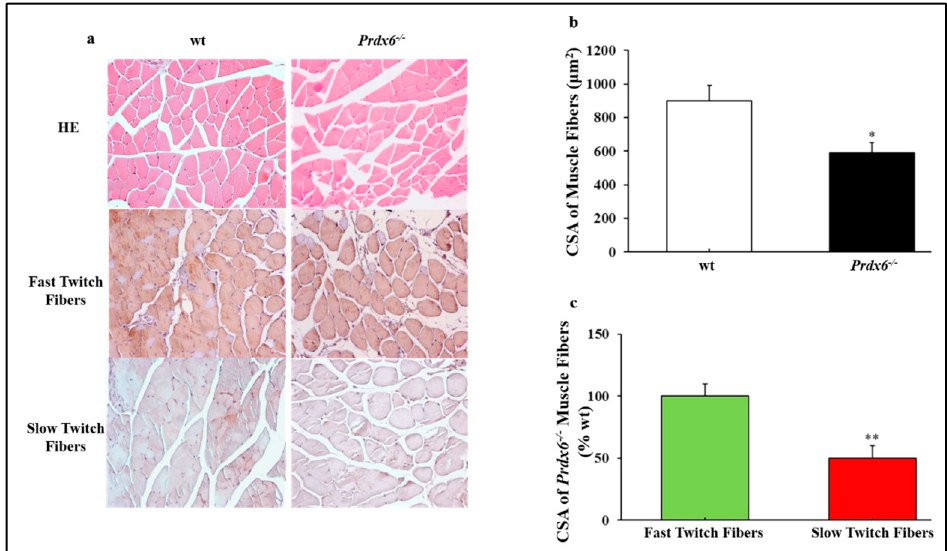
Figure 4. Histology evidences skeletal muscle atrophy in Prdx6 -/- mice. (a) HE and immunohistochemical staining for fast and slow myosin heavy chain (magnification 20×). (b) CSA of muscle fibers ( μ m 2 ). (c) CSA of Prdx6 -/- fast and slow muscle fibers expressed as percentage of wt. * p < 0.05 and ** p < 0.01 Prdx6 -/- vs wt. ( n = 5 mice per group). HE = Hematoxilin-Eosin; CSA = cross-sectional area.